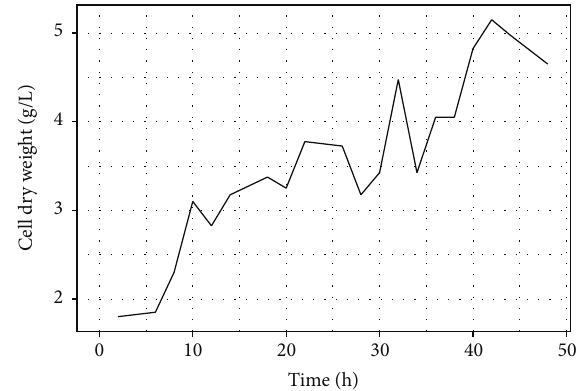
Figure 4: Cell dry weight of L. rhamnosus ATCC 10863 at fed batch fermentation